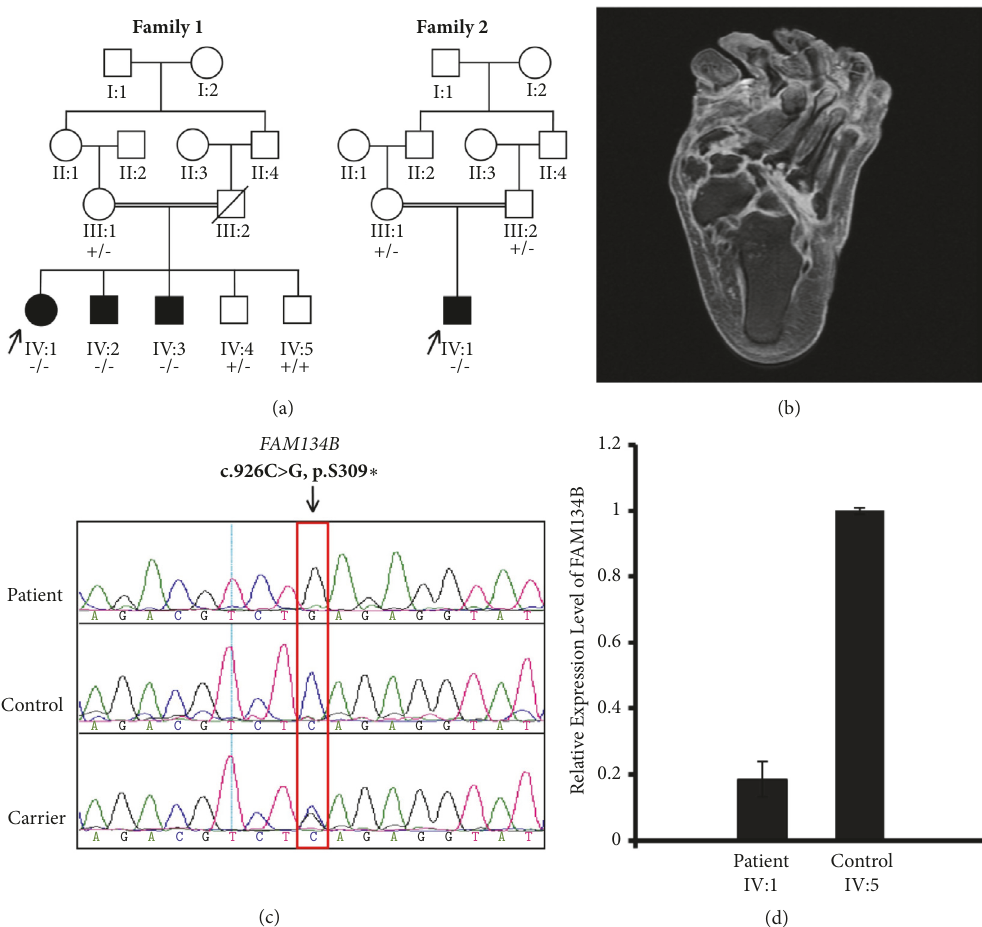
Figure 1: (a) Pedigree of the described Family 1. Parents (III: 1 and III: 2) of the affected individuals (IV: 1, IV: 2 and IV: 3) are first degree relatives. Family 2 Parents (III: 1 and III: 2) of the affected individuals (IV: 1) are first degree relatives. Filled boxes indicate individuals affected by hereditary sensory neuropathy and open boxes indicate phenotypically normal individuals. Homozygous mutant genotype (-/-), heterozygouscarrier ( + /-),and homozygous wild-type genotype ( + / + )were observed.(b) MRI of thefoot for the affectedindividual IV:1 from Family 1. Notethemarked deformity in the toewith metatarsal boneand scartissue formation. (c)Sanger sequencinganalysis of the FAM134B gene (NM 001034850)identified a homozygous variant (c.926C > G, p.S309 ∗ ) in the affected individual (upper panel), homozygous wild type inthenormalcontrol(middlepanel)andheterozygousinthecarriermother(lowerpanel).(d)QuantitativerealtimePCRof FAM134B mRNA for patient IV: 1 from family 1 and his normal sibling IV: 2 showing significant reduction of the transcript level.The experimentwas performed in quadruplicate; error bars represent standard error of the mean while the relative expression of FAM134B in controls is set to one and data are normalized to GAPDH